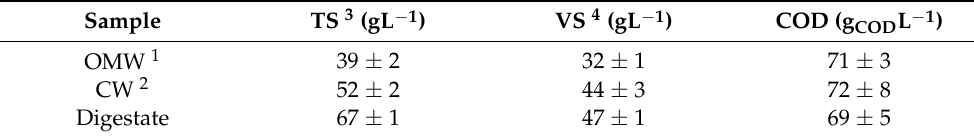
Table 1. Characteristics of the used inoculum and substrates.